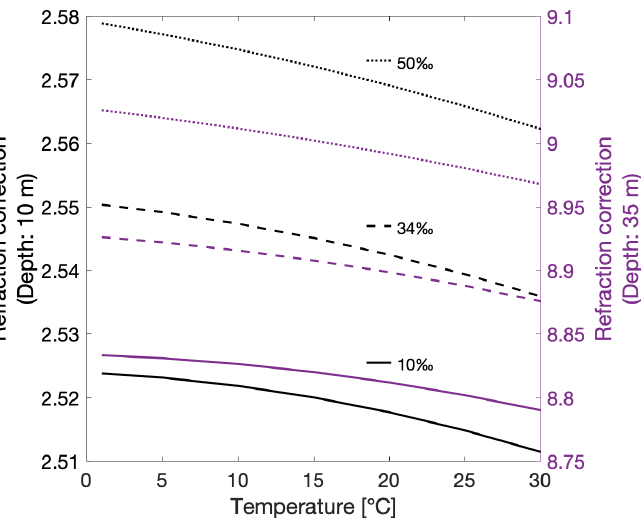
Figure 6. Vertical refraction correction as a function of temperature for three different salinities and at two different depths of 10 m (left y -axis) and 35 m (right y